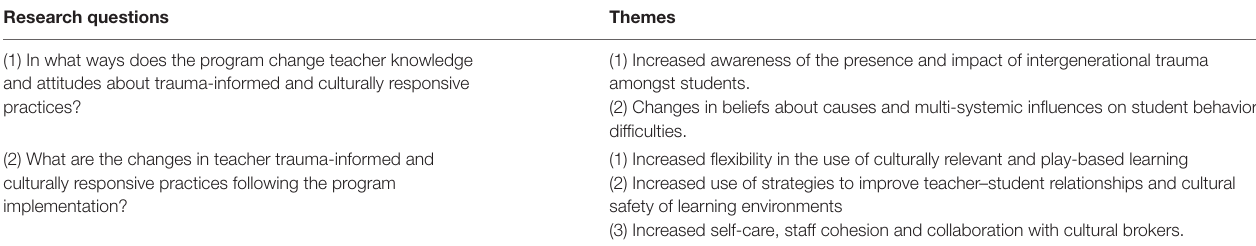
TABLE 1 | Key research questions and the corresponding themes identified in the